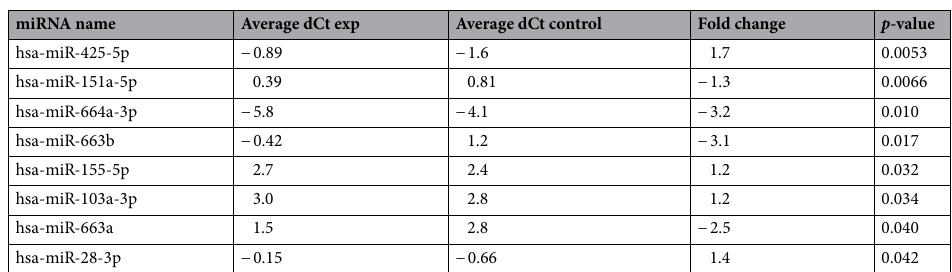
Table 1. Differentially expressed miRNAs in HK-2 cells-derived exosomes under high glucose versus low glucose conditions. p -value was determined by two tailed Student’s t-test or Wilcoxon test as appropriate. miRNA, Micro Ribonucleic Acid; HK-2, Human Kidney Proximal Tubular Cells; hsa, Human; dCt, Normalized Threshold Values; exp, Experimental Sample (High glucose treated exosome sample); control, Low glucose treated exosome